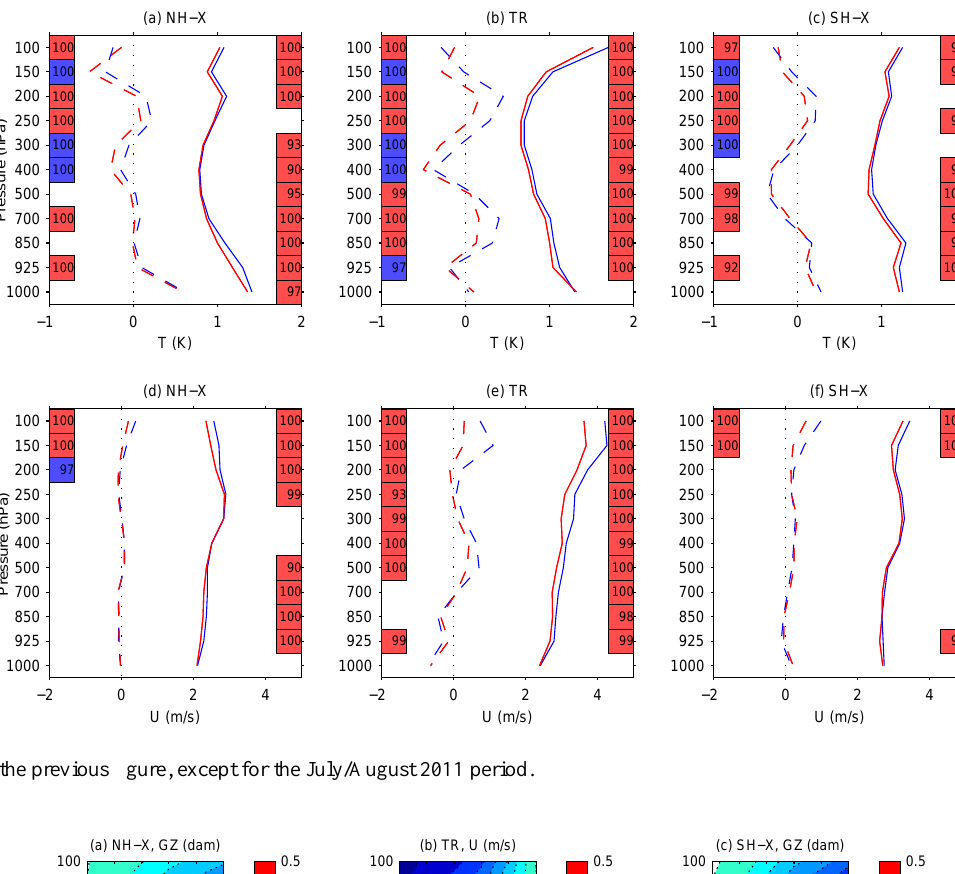
Fig. 4. Same as the previous figure, except for the July/August 2011 period.